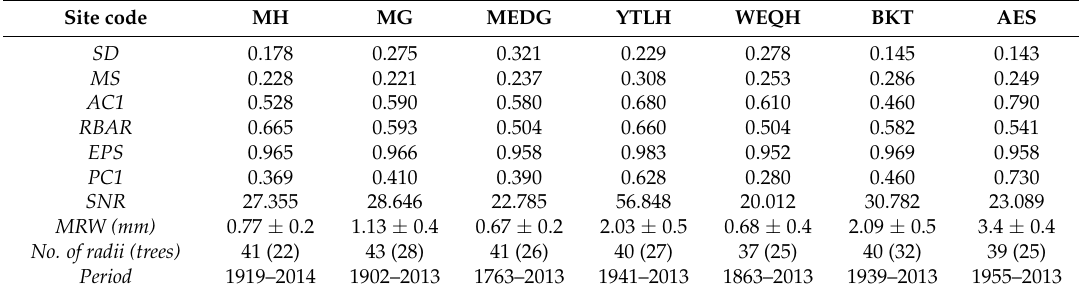
Table 2. Statistical characteristics of Larix gmelinii residual chronologies along the latitudinal gradient from 47 ◦ to 53 ◦ N in the western Greater Khingan Mountains,